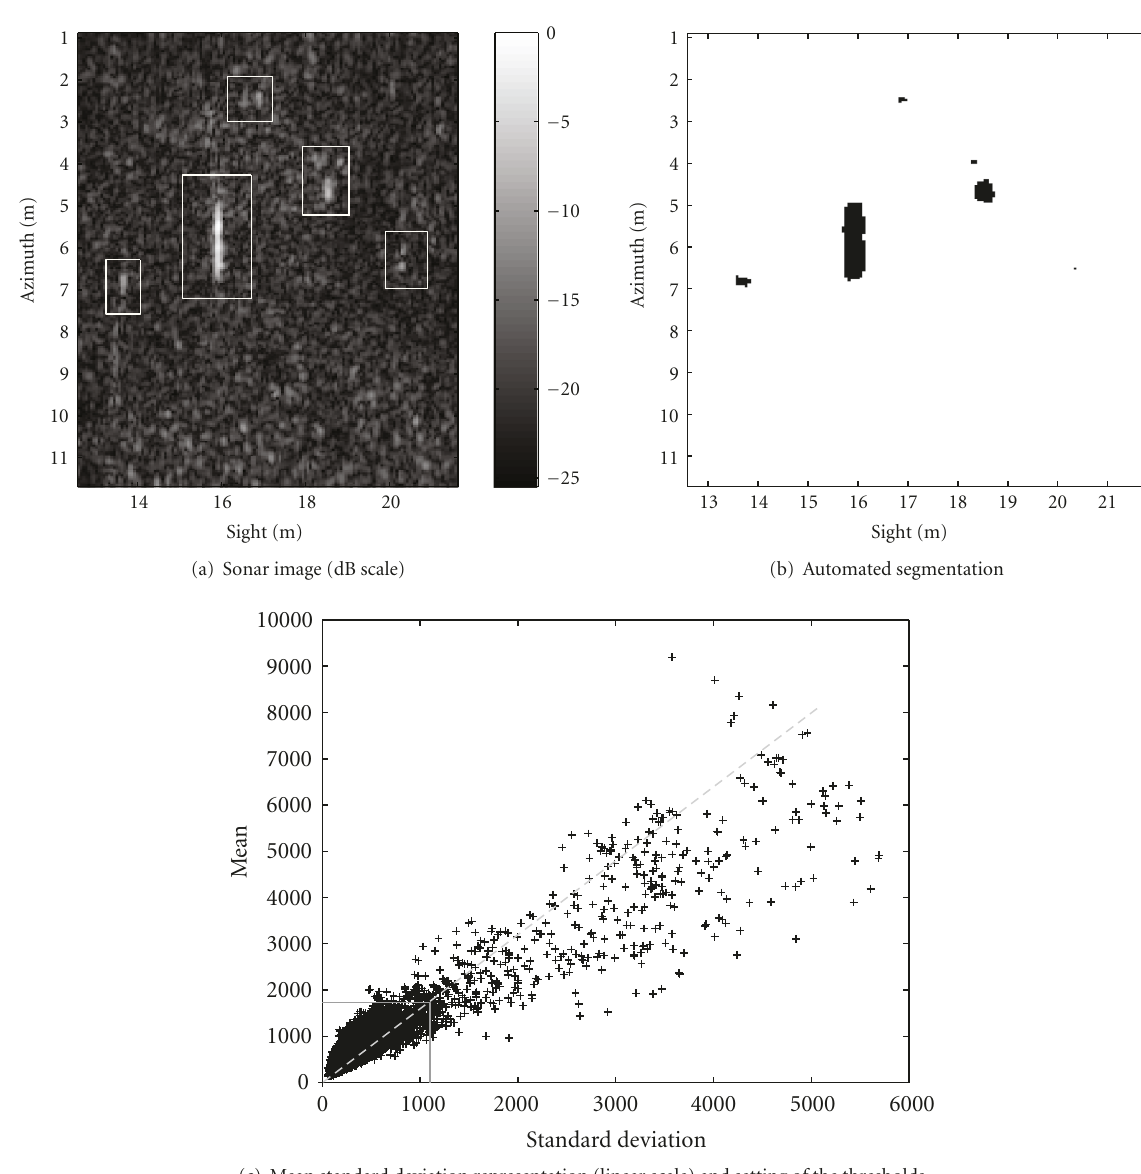
Figure 3: Automated segmentation of a sonar